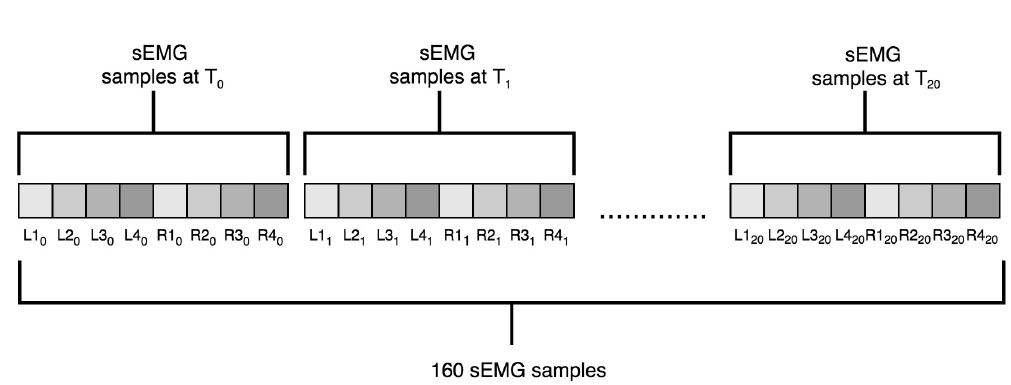
Figure 4. The structure of EMG vectors fed as input to the artificial neural networks